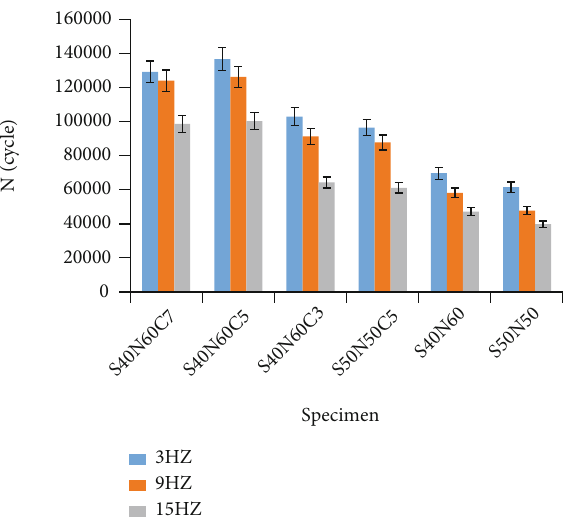
Figure 10: Fatigue life changes of di ff erent samples at 70% strain and frequencies of 3 Hz, 9Hz, and